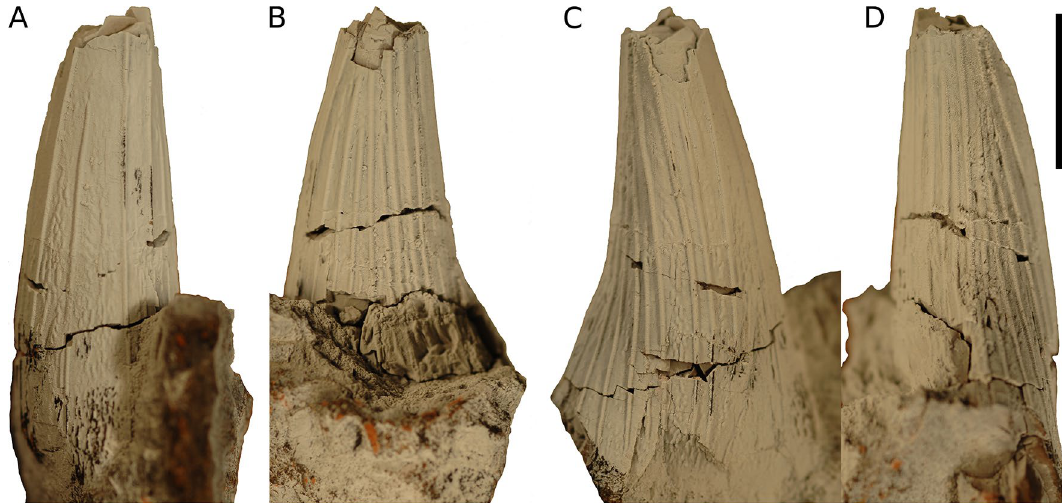
Figure 3. MCNC-1830 in ( A ) mesial, ( B ) lingual, ( C ) labial, and ( D ) distal view. Scale bar = 10 mm. Photographs taken by Dylan Bastiaans. Figure created by Daniel Madzia using the free online application Photopea (https:// www. photo pea.